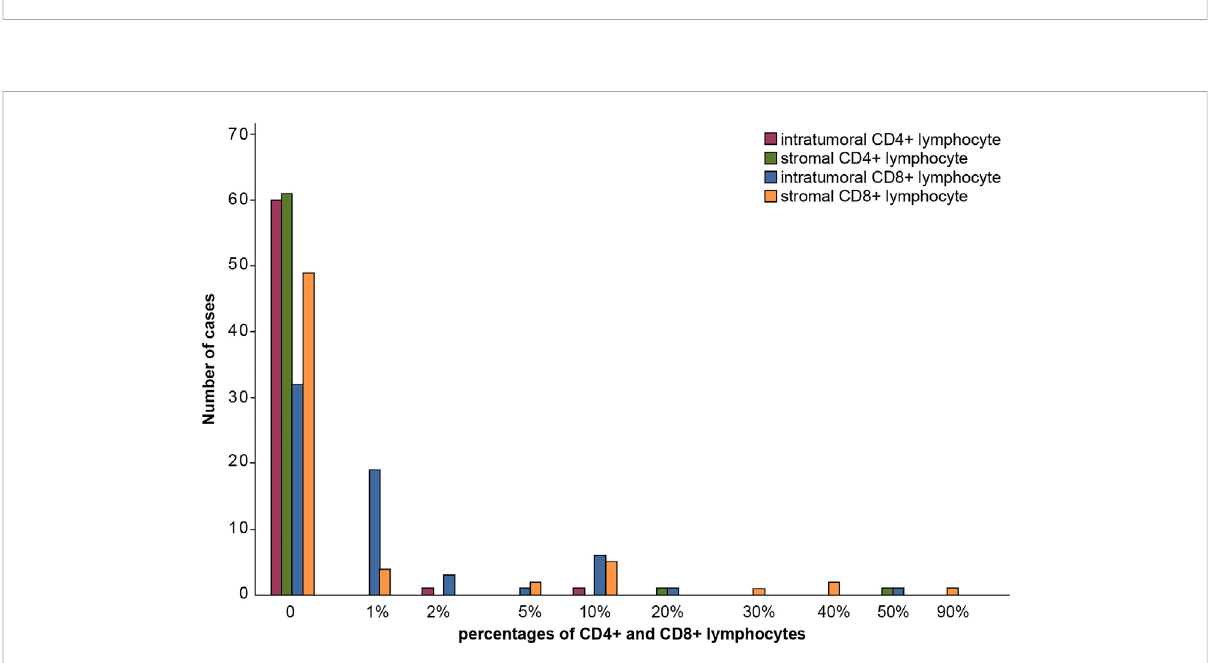
FIGURE 5 Percentage of intratumoral and stromal CD4 + and CD8 + in fi ltrating lymphocyte.